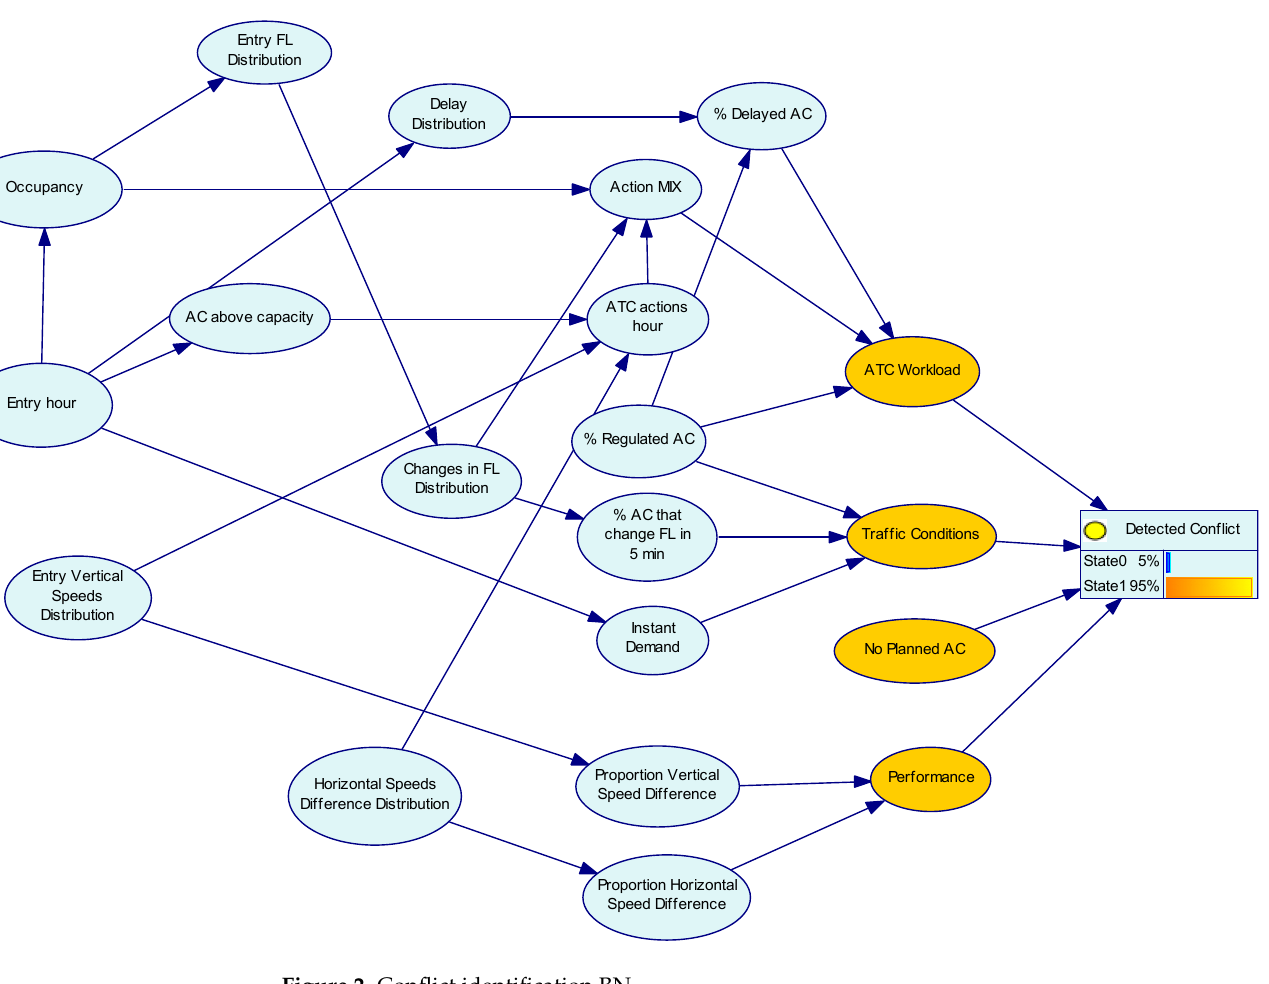
Figure 2. Conflict identification BN .